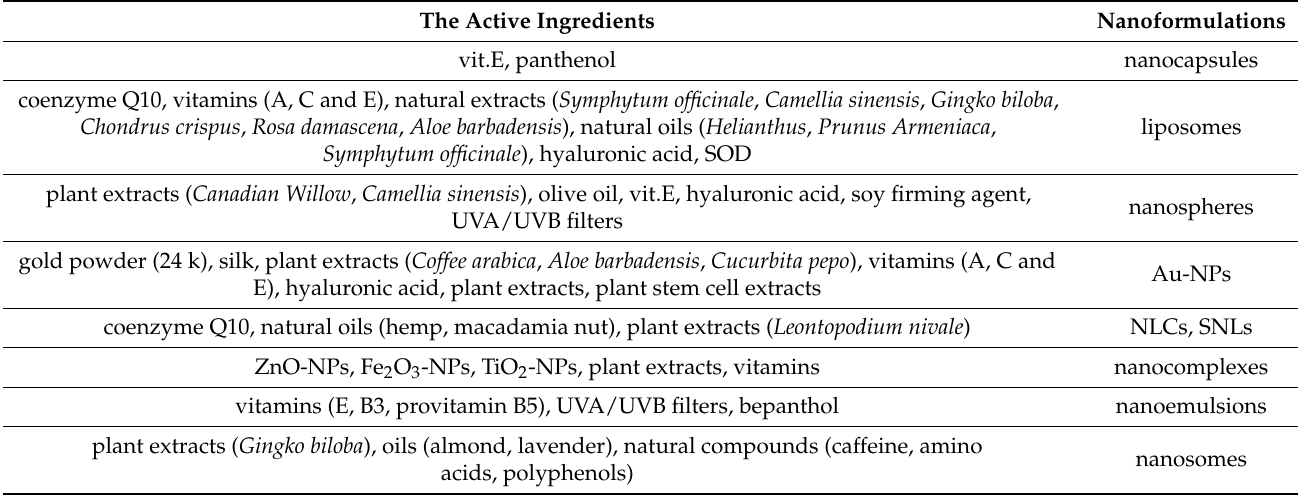
Table 2. Types of commercial skin care nanoformulations with their active